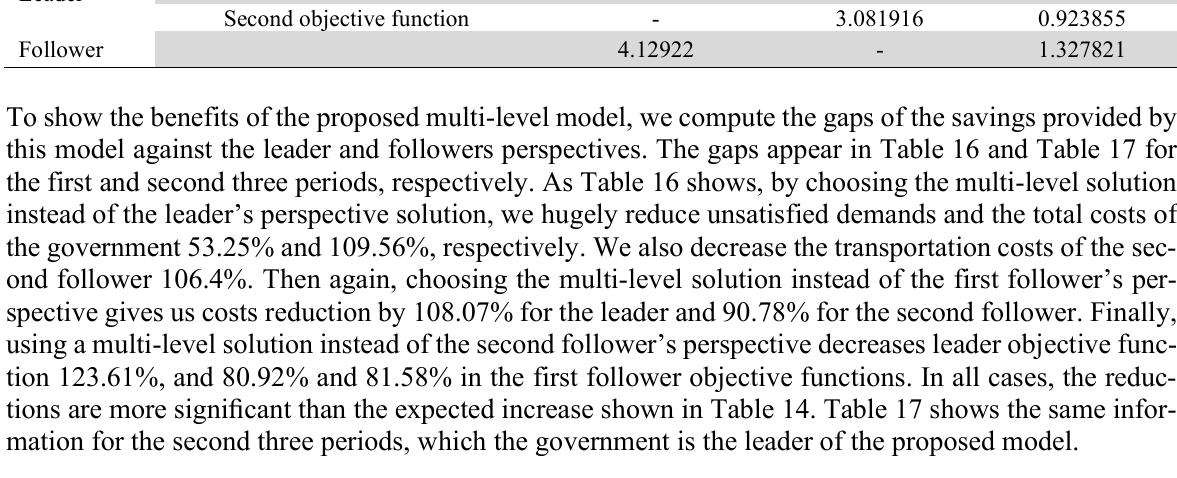
Percentage of increase in the respective models against the best decision for the second three periods Leader